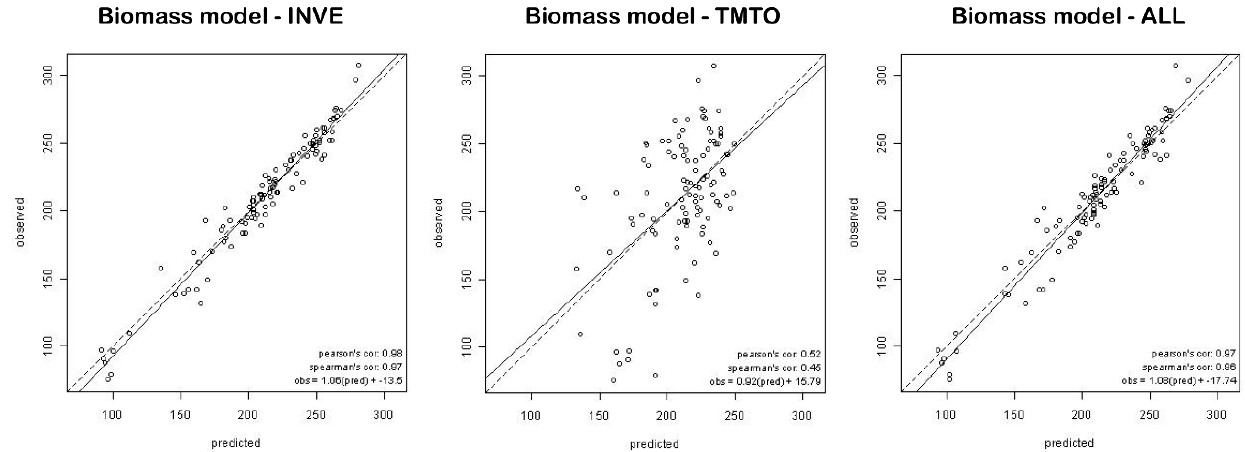
Figure 3. Correlation coefficients for biomass prediction, based on the INVE, TMTO and ALL